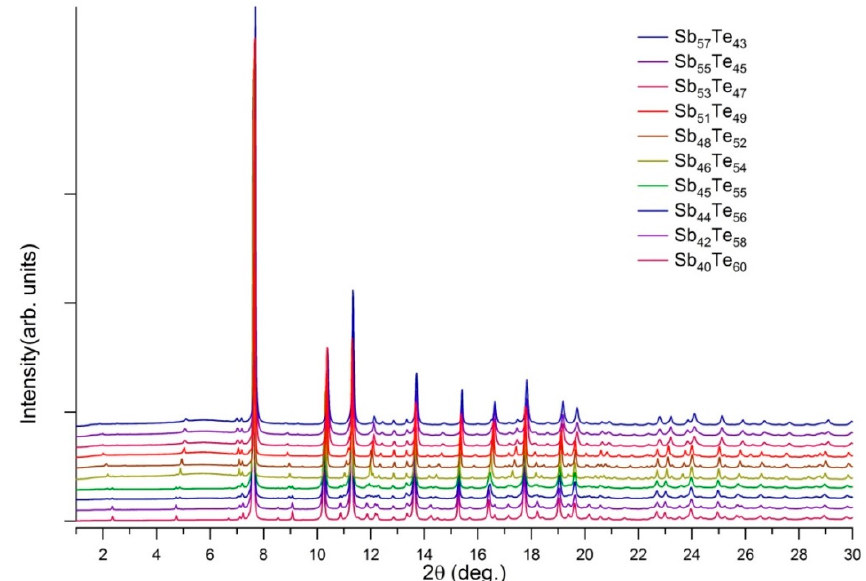
Figure 2. X-ray powder di ff raction profiles of Sb–Te specimens acquired at 90